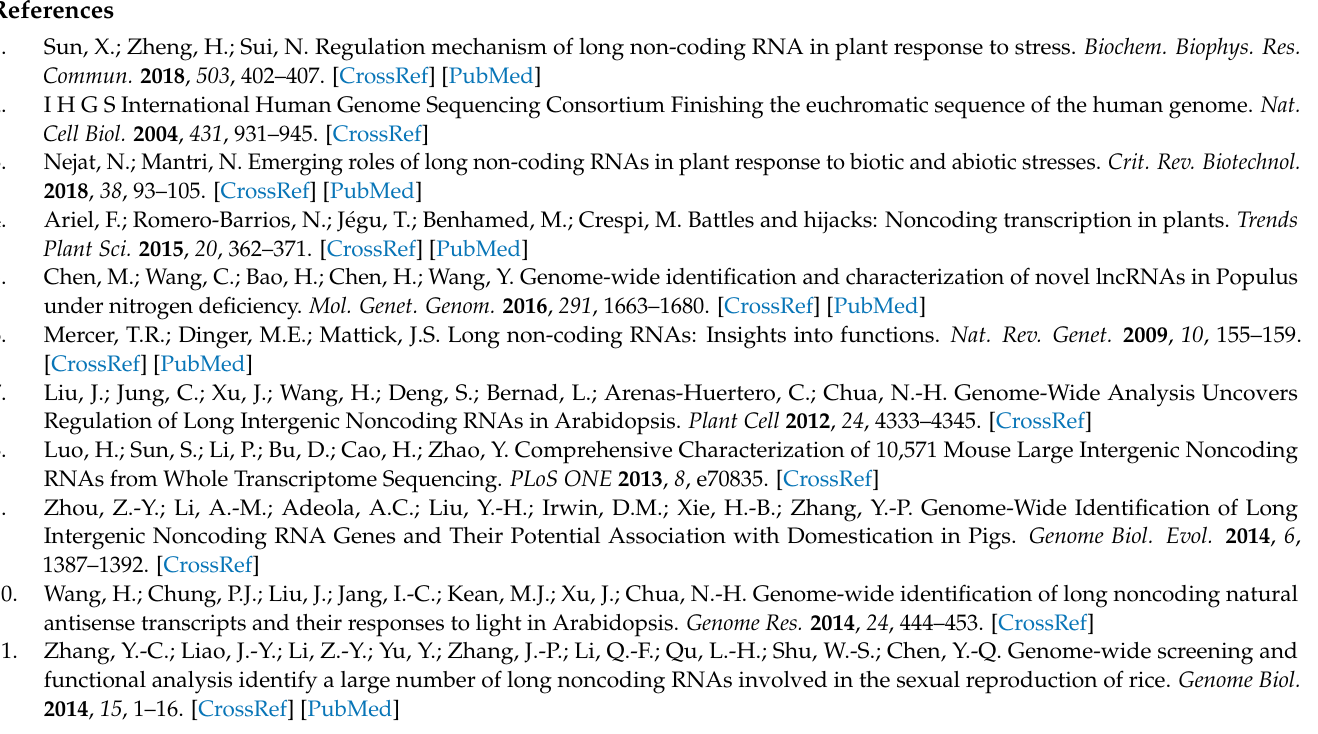
Table S4: All of Novel lncRNA annotation information in this study; Text S1: All of Novel lncRNA sequences were identifted in this study; Figure S1: The interaction network among lncRNAs, miRNAs and miRNA target protein-coding genes, Figure S2: Full Western blotting image for Figure 5C—Anti- CWMV CP; Figure S3: Full Western blotting image for Figure 5C—CBB; Figure S4: Full Western blotting image for Figure 6E—CBB; Figure S5: Full Western blotting image for Figure